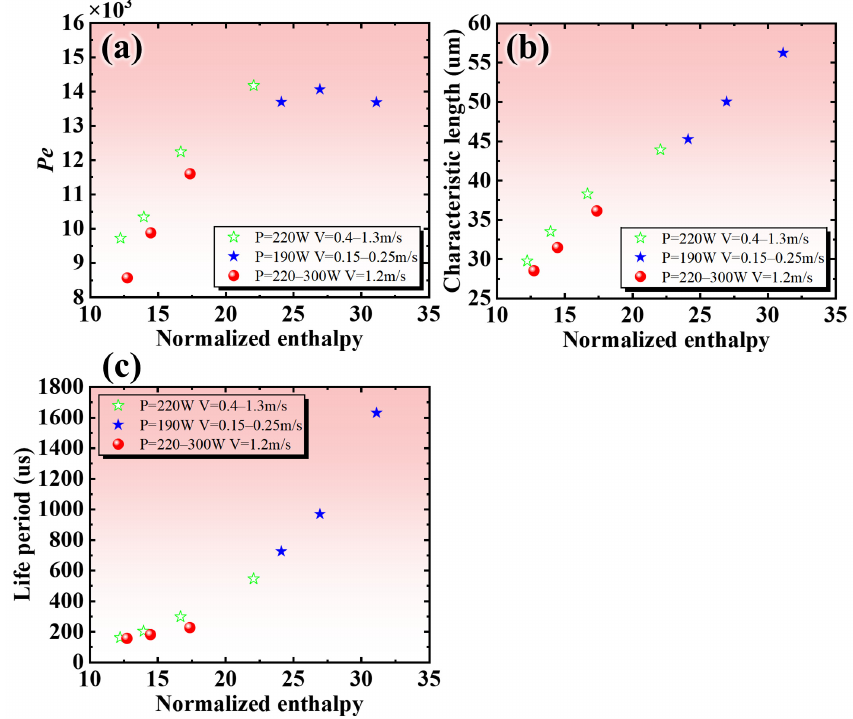
Figure 8. The characteristics of molten pool at various scanning rates and laser powers: ( a ) Pe; ( b ) characteristic length; ( c ) life period. ( b ) characteristic length; ( c ) life